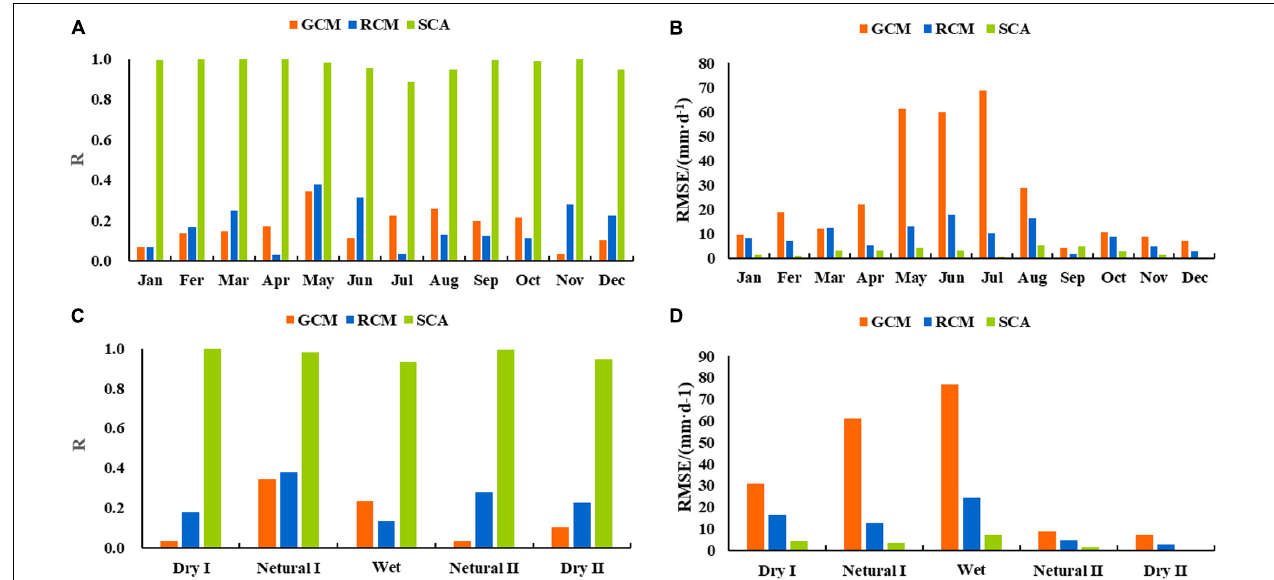
FIGURE 9 | Verification of precipitation simulation and observed data in different scale models: (A) monthly correlation coefficient; (B) monthly RMSE; (C) correlation coefficient in period; (D) RMSE in period.